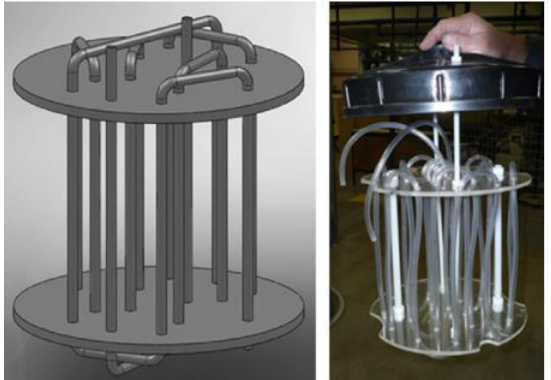
Figure 1 Schematic and photo of the experimental PCM tank with higher packing factor[17]